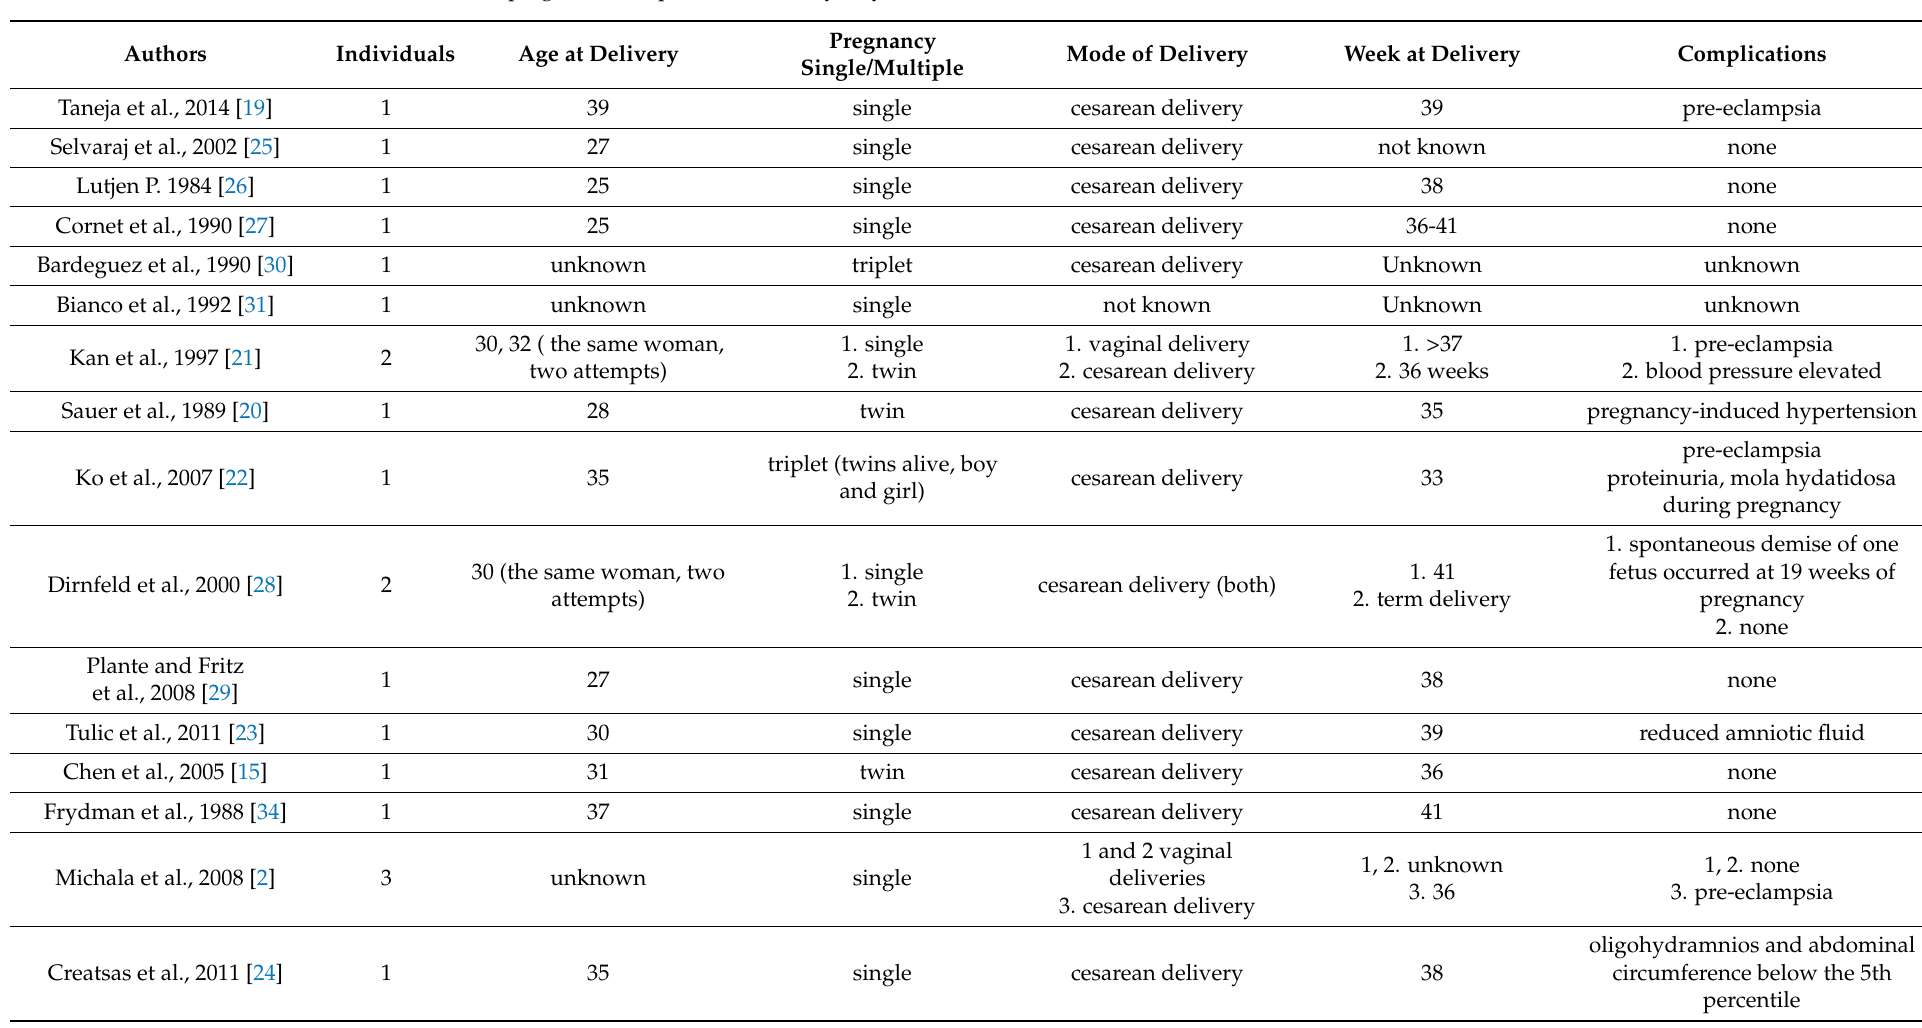
Table 4. Cases of pregnancies in patients with Swyer